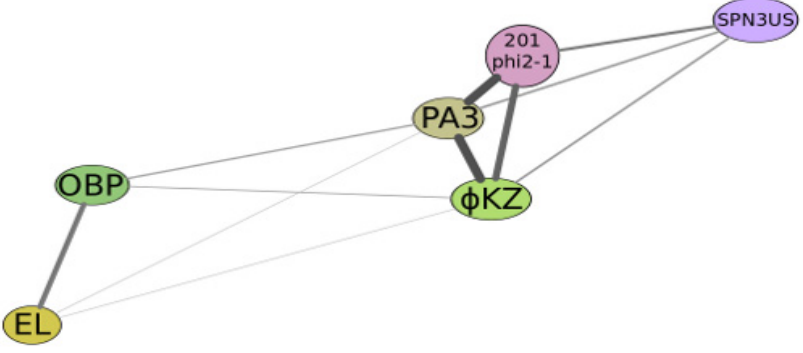
Figure 5. The growth of different phages on P. aeruginosa PAO1 and on clinical isolate P. aeruginosa Che1. Temperate phage phi 297w does not lysogenize cells of Che1